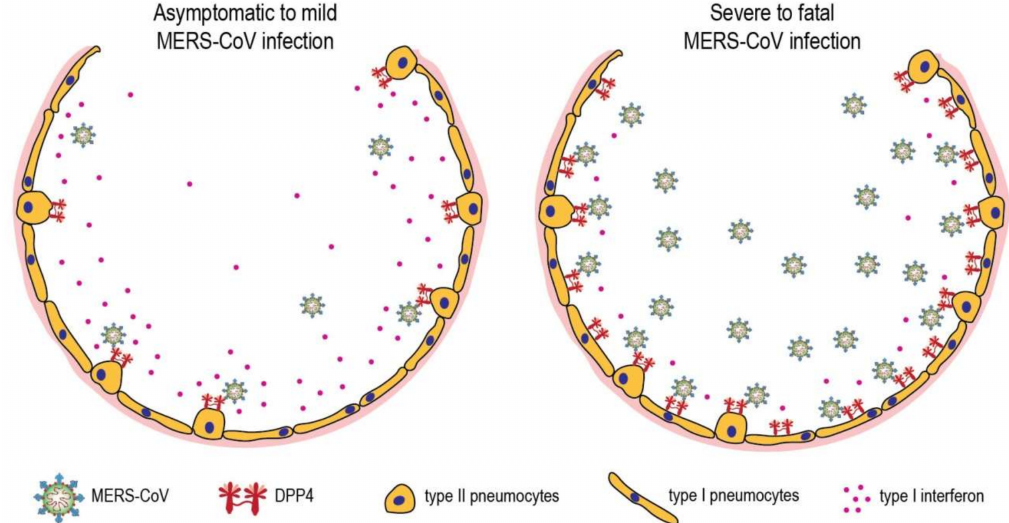
Figure 4. MERS-CoV infection in the lungs of asymptomatic-to-mild (left panel) and severe-to-fatal cases (right panel). Shown is a hypothetical model with two critical host determinants, DPP4 and interferon, differentially expressed in asymptomatic-to-mild and severe-to-fatal MERS-CoV